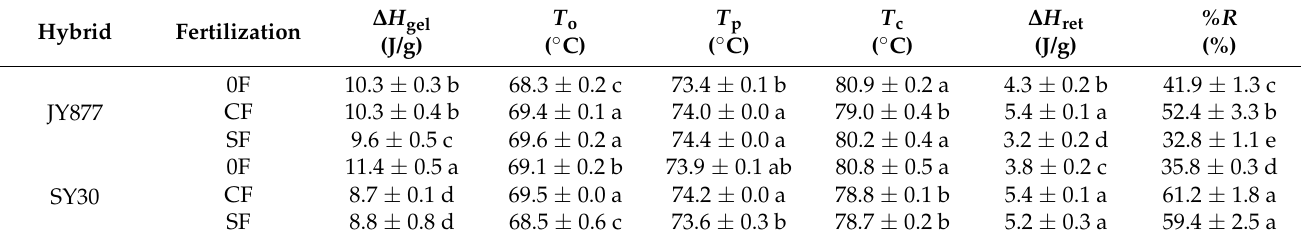
Table 3. Effects of the fertilization mode on starch thermal properties of normal